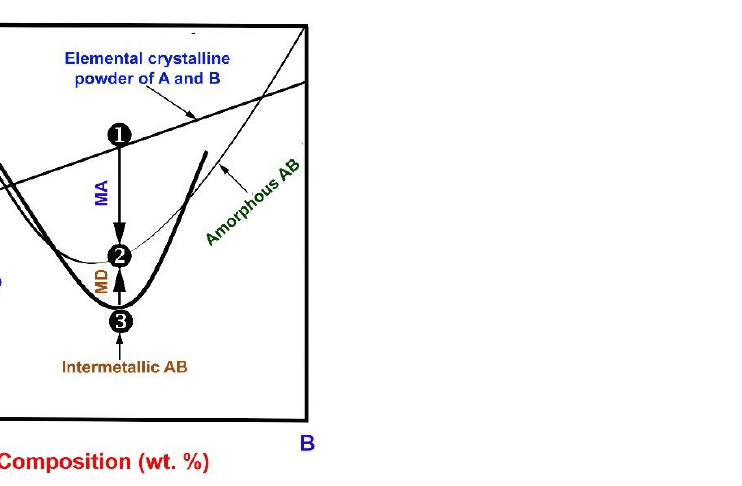
Figure 2. Diagrammatic illustration of the free energy (DG) for the phases engaged in the mechanical alloying and mechanical disordering processes, commencing with (1) a mixture of two elemental powders (A + B), and (2) an intermetallic phase of AB exposed to the MA and MD processes, respec- tively.